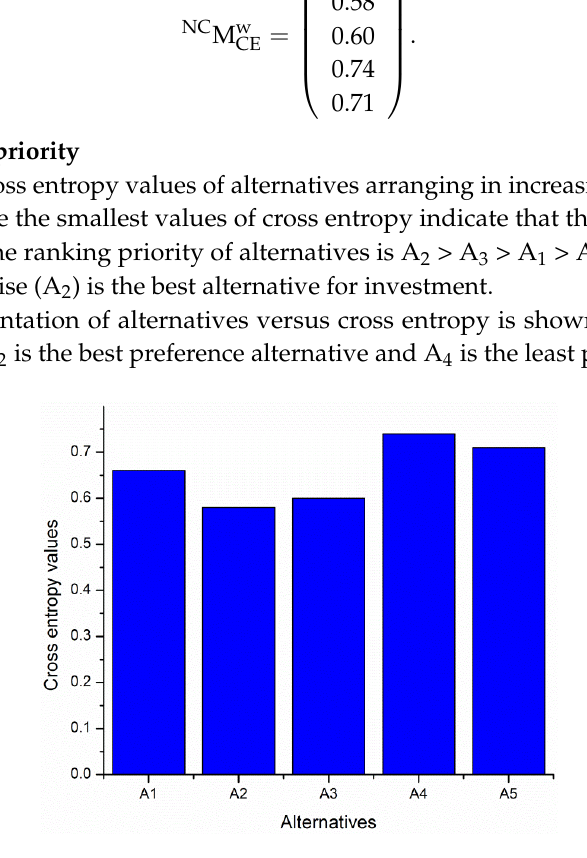
Figure 2. Bar diagram of alternatives versus cross entropy values of alternatives.